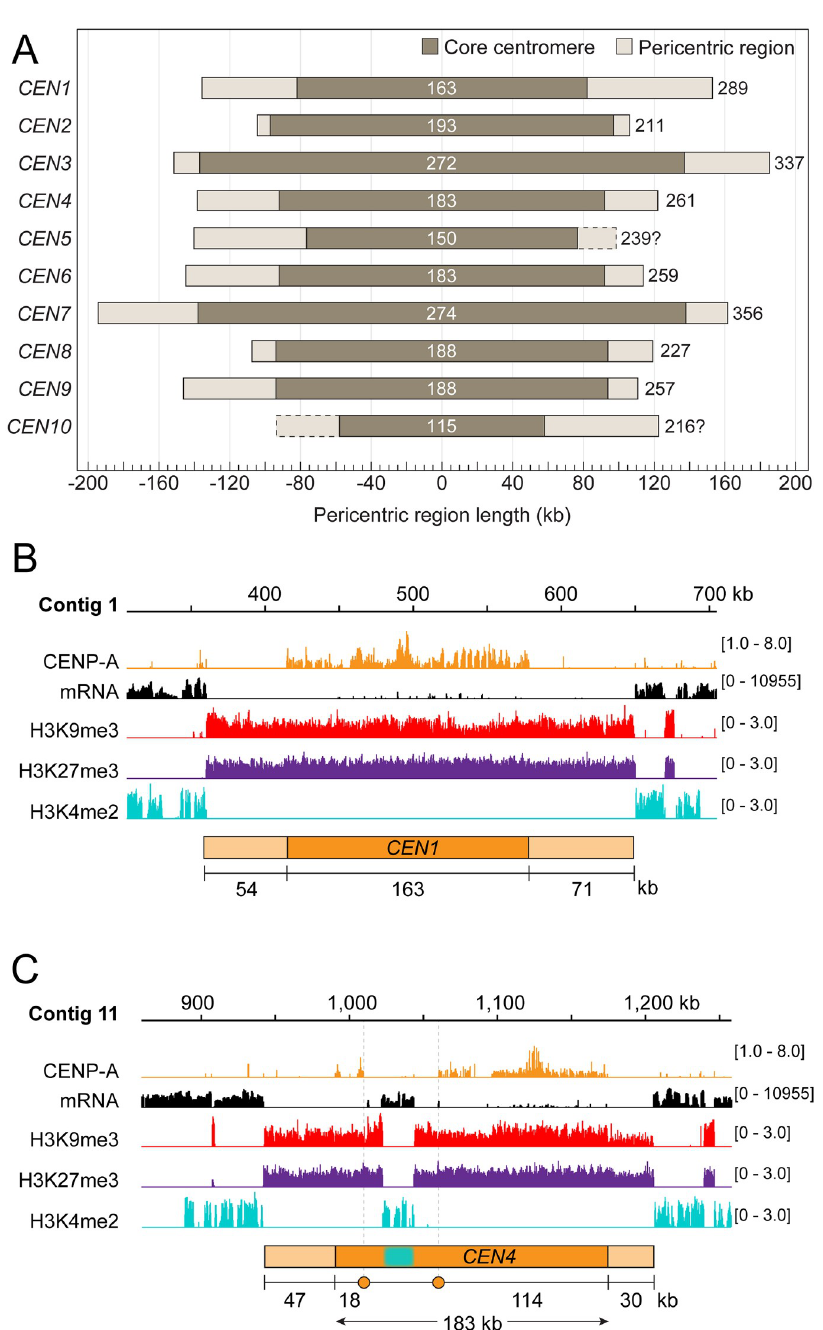
Fig 4. Epigenetic state of P . sojae centromeres. (A) Schematics showing the P . sojae core centromeres (CENP-A binding regions) and the pericentric regions of various lengths. Dark and light grey bars indicate core centromeric and pericentric regions. Numbers at the center indicate the size of core centromeres; Numbers on the right denote the full- length of the centromeres (a combination of core centromere and pericentromeric region). The right pericentric region of CEN5 and the left pericentric region of CEN10 , indicated by dashed bars, are not fully assembled, and their lengths are labeled with question marks. (B-C) Two centromeres ( CEN1 and CEN4 ) are shown as representatives to compare CENP-A localization to the distributions of modified histones. A 400 kb region harboring the centromeric region is shown for CEN1 and CEN4 . Cyan block, a transcriptionally active region (21 kb) that interrupts CEN4 . Profiles of CENP-A, H3K9me3, H3K27me3 and H3K4me2 shown were normalized to input. mRNA profiles are shown as log-scales. Orange circles in (C) delimit borders of a CENP-A binding void.